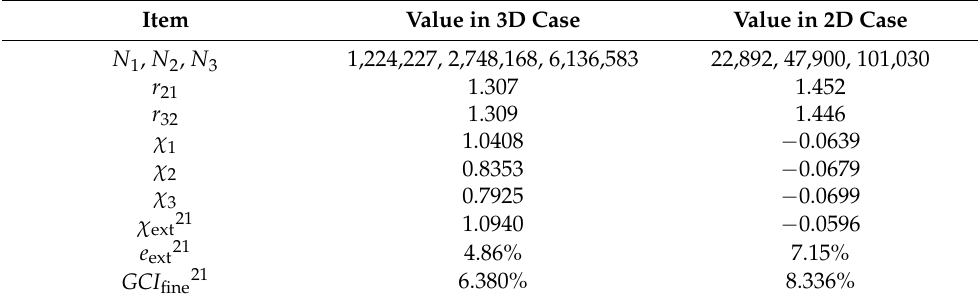
Table 3. Grid convergence analysis based on the flow rate coefficient C ϕ for 3D CFD simulations and the damping ratio ζ α for 2D coupling simulations at α = 0.2 ◦ and C ψ = 1.133.